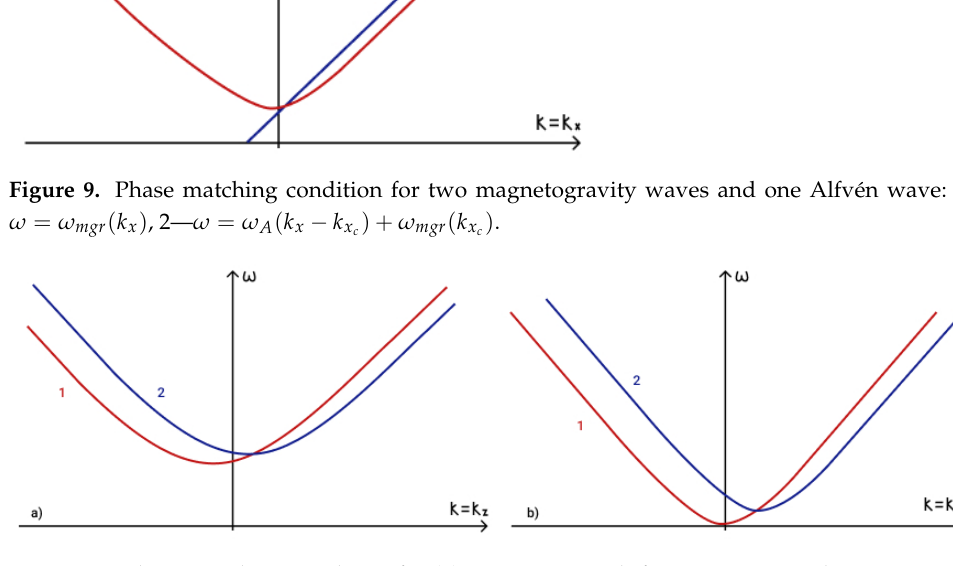
Figure 10. Phase matching condition for ( a ) two waves with frequency ω z 1 and one wave with frequency ω z 2 : 1— ω = ω z 1 ( k z ) , 2— ω = ω z 2 ( k z − k z ω z 2 : 1— ω = ω z 2 ( k z ) , 2— ω = ω z 2 ( k z − k z